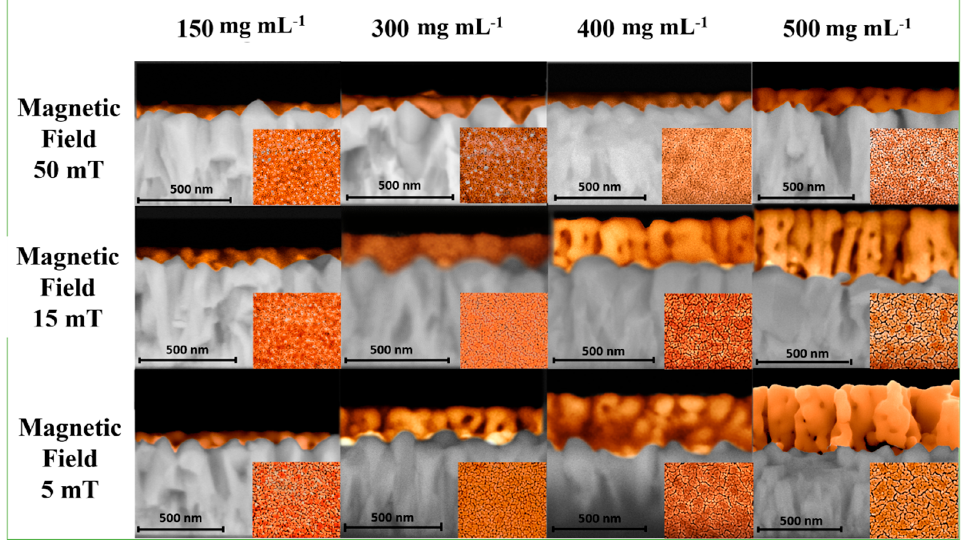
Figure 3. Cross-sectional SEM images and top-view (inset figures) of hematite nanostructures ob- tained for different magnetic fields and nanoparticle concentrations. obtained for different magnetic fields and nanoparticle